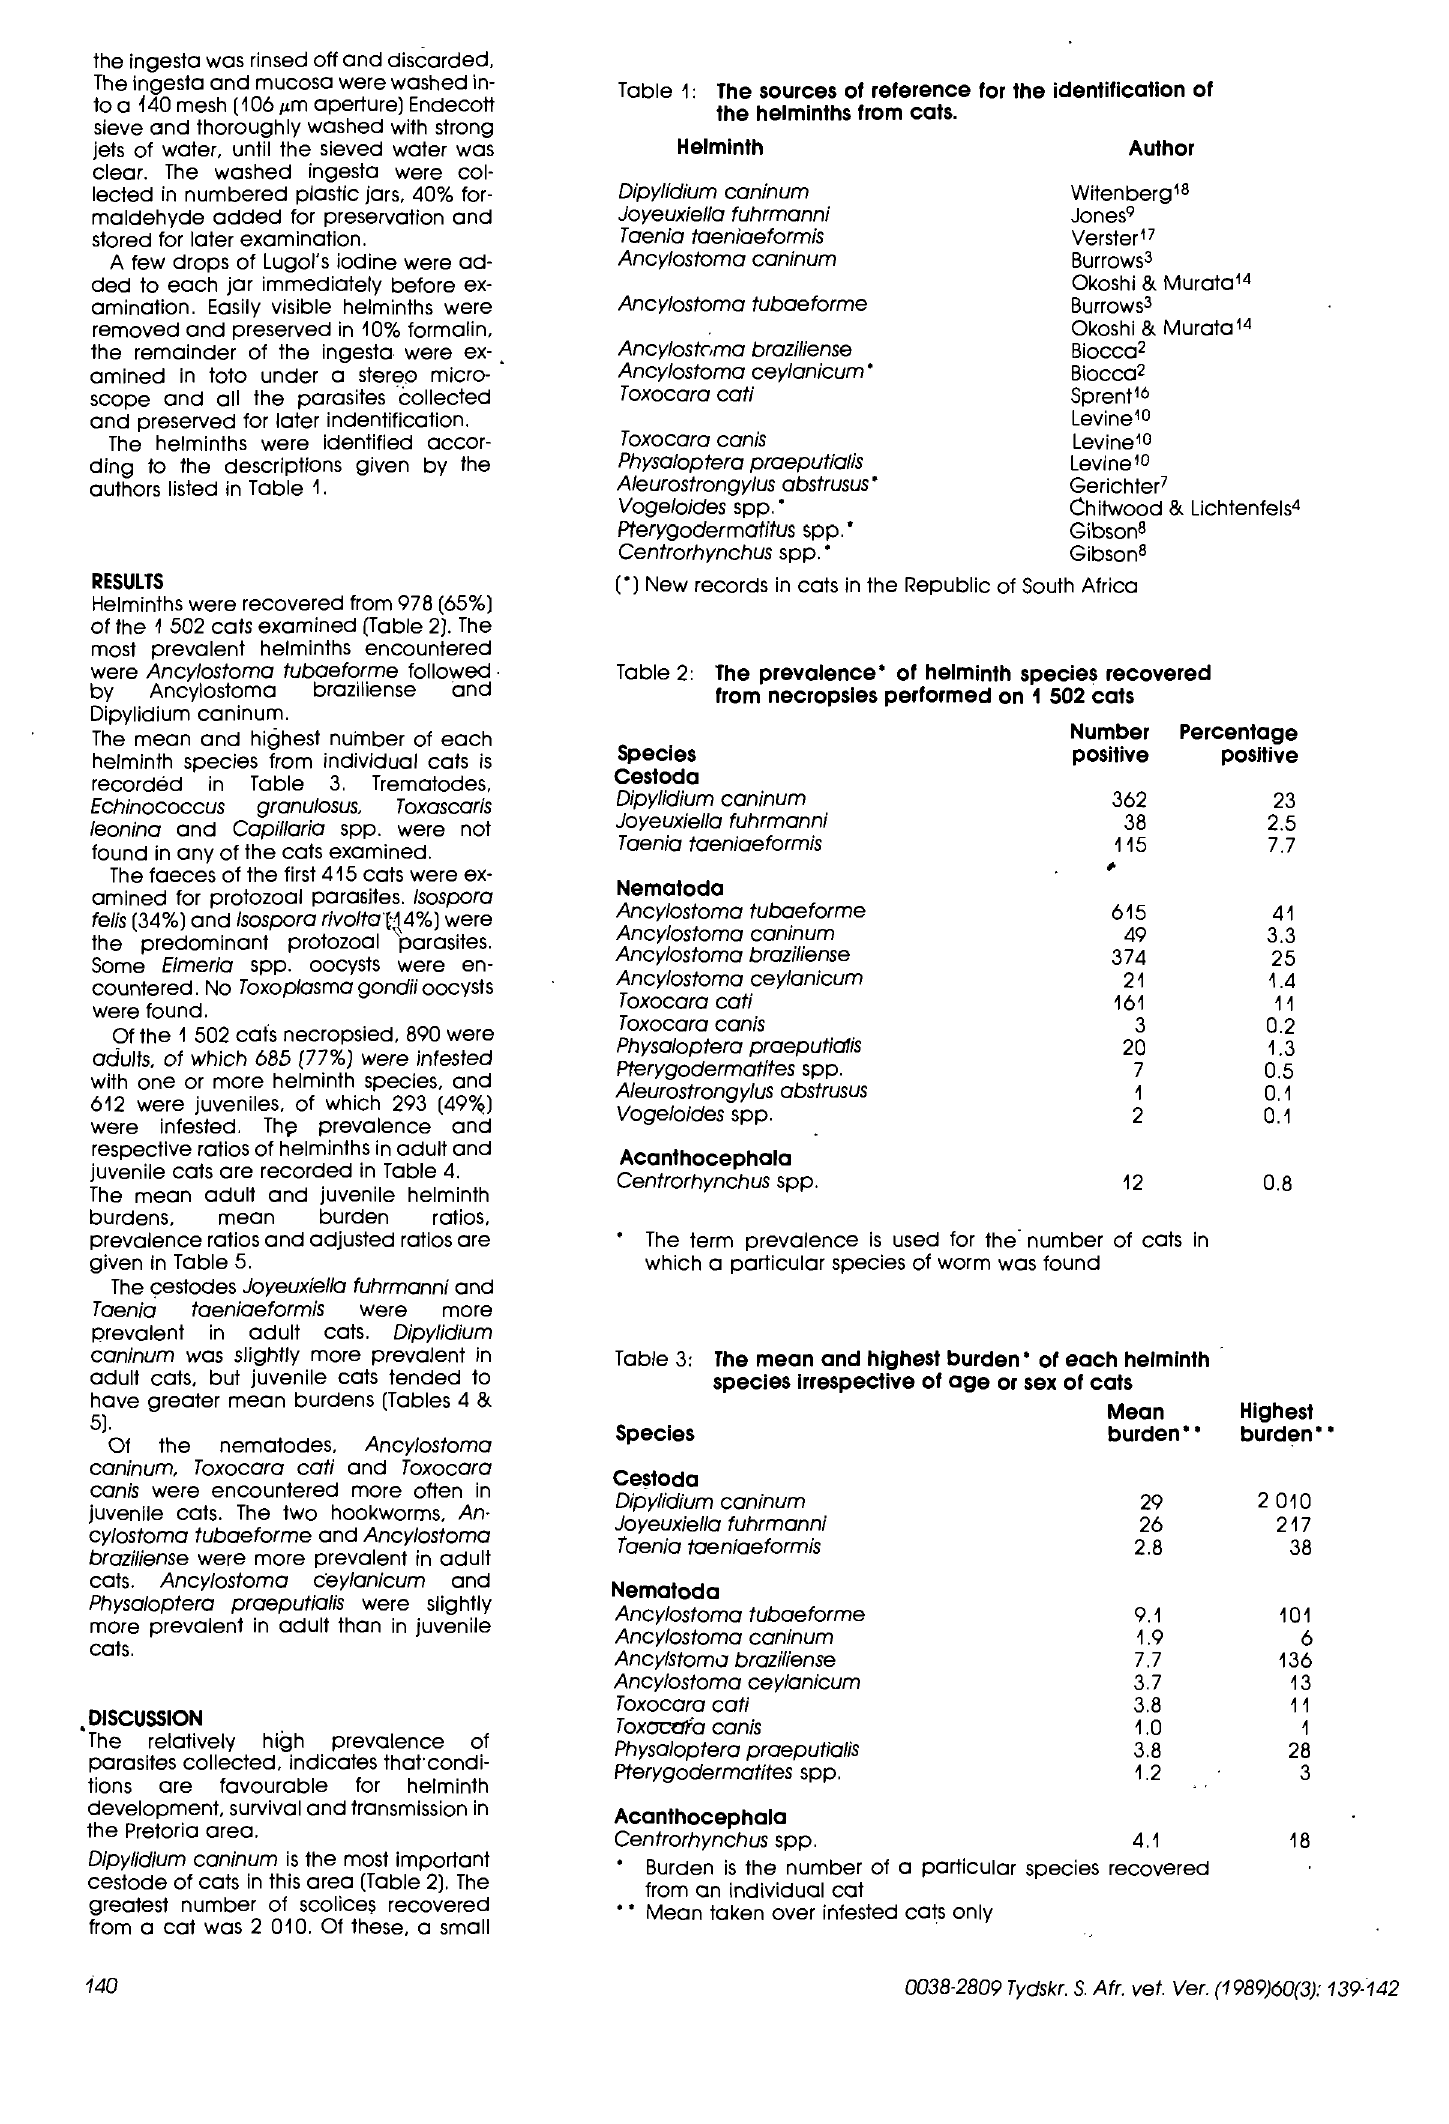
Table 2: The prevalence' of helminth species recovered from necropsies performed on 1 502 cats